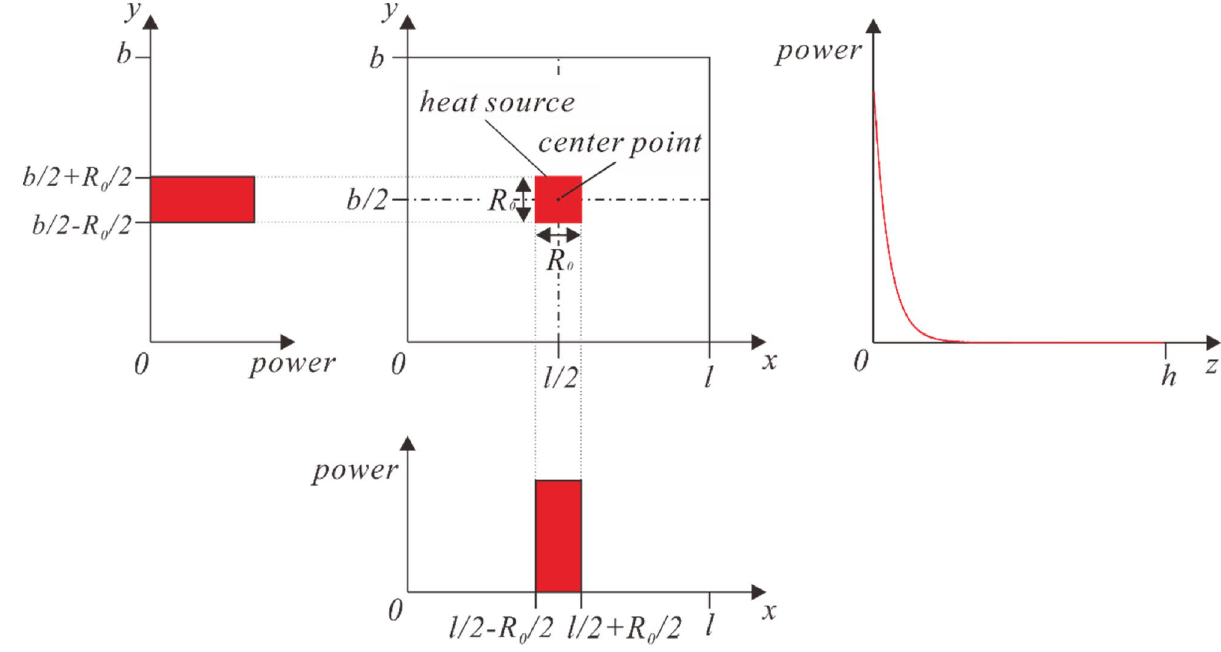
Figure 2. Spatial distribution of the heat source power.